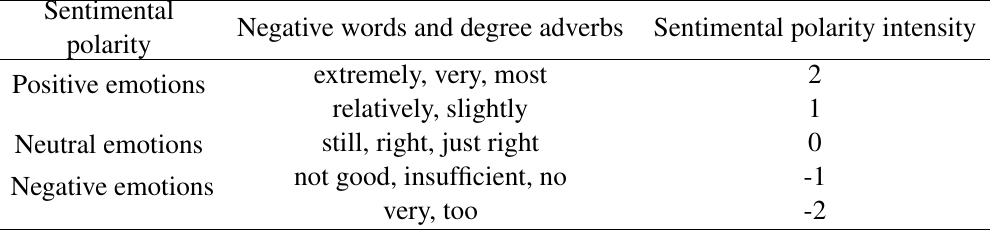
Table 1 The quantitative rule for the intensity of sentimental polarity